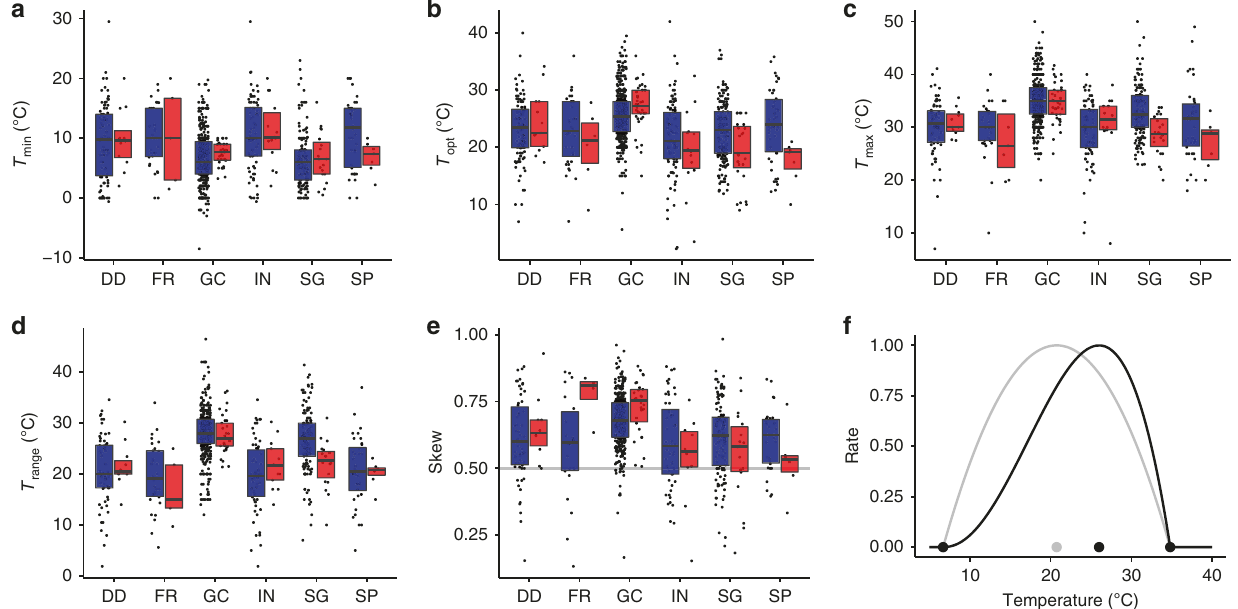
Fig. 1 Temperature responses of plant-associated fungi (blue) and oomycetes (red) life history processes. a Minimum temperature ( T min ), b optimum temperature ( T opt ), c maximum temperature ( T max ), d temperature range ( T max – T min ). e Skew, where values >0.5 indicate the T opt is closer to T max than T T T T fi cation (FR), growth in culture min . The grey line indicates where opt lies half-way between min and max . Processes are disease development (DD), fruiti (GC), infection (IN), spore germination (SG), and sporulation (SP). a – e Boxplot boundaries re fl ect the inter-quartile range, the horizontal bar is the median. Summary statistics including sample sizes are reported in Supplementary Table 1. f Illustration of skew for a temperature response function. The black points show cardinal temperatures, with midpoint between T min and T max in grey. Unskewed response in grey, skewed response in